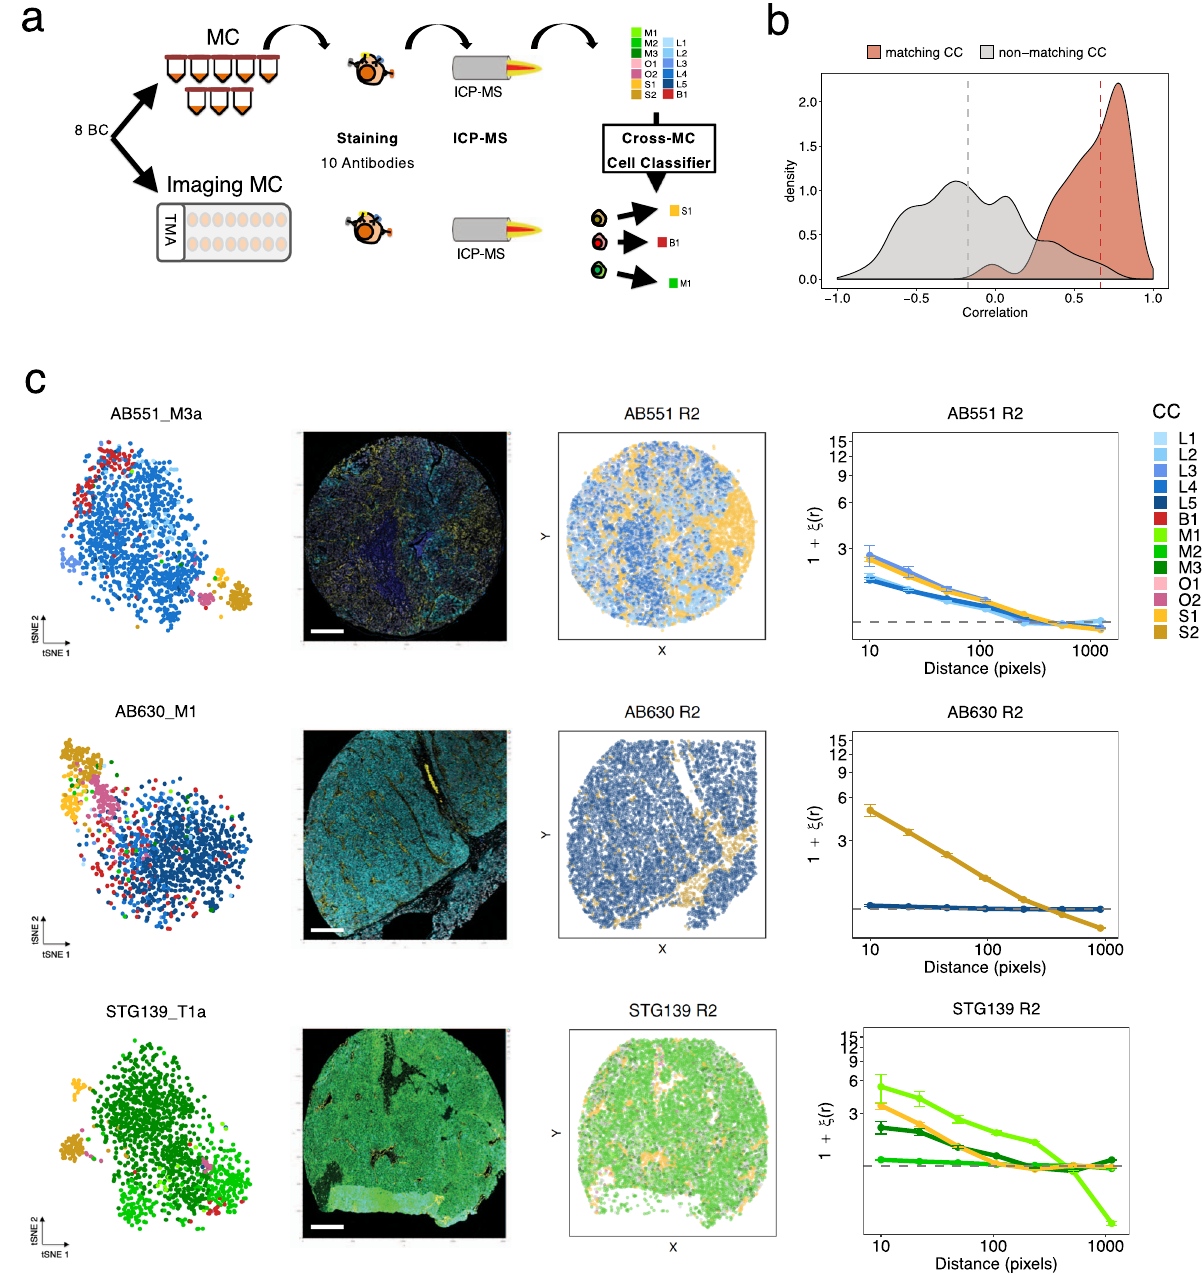
Fig. 4 Imaging mass cytometry reveals the spatial distribution of cell phenotypes in xenografts. a Schematic representation of model-speci fi c cross- mass cytometry cell-classi fi er ( N samples = 15, N markers = 10, N cells = 99,336). From mass cytometry (MC) data, a model-speci fi c cell-cluster (CC) classi fi er was trained and applied to imaging mass cytometry (IMC) from tissue microarray (TMA) segmented cells from the same model in order to classify cells into one of the CCs. b Distribution of MC-IMC centroid correlations (matching CC centroids in red; non-matching CC centroids in grey). Median values of matching and non-matching CC centroids are indicated by dashed vertical lines. c Examples of mapping of MC CCs to IMC data for AB551_M3a, AB630_M1 and STG139_T1a. From left to right: tSNE plot based on MC pro fi ling coloured as in Fig. 3b; IMC image coloured for a subset of relevant markers representative of distinct CCs; pseudo-image with segmented cells labelled according to the classi fi er coloured as in Fig. 3b; two-point autocorrelation analysis results for each CC quantifying the deviation from a random cell distribution as a function of distance. Data are presented as mean values ±